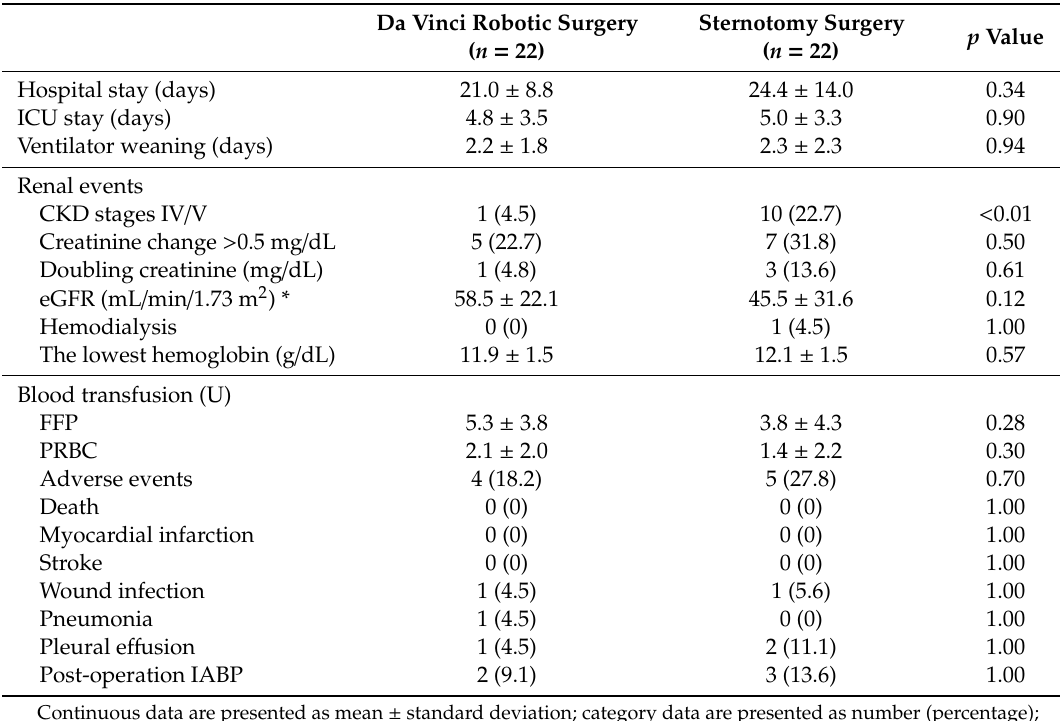
Table 2. Adverse events in hospital between two surgical modalities.